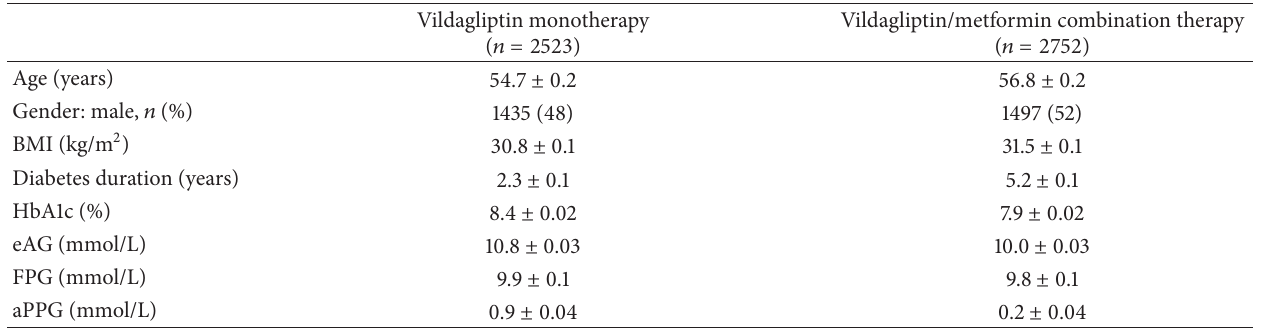
Table 1: Patient demographics and baseline